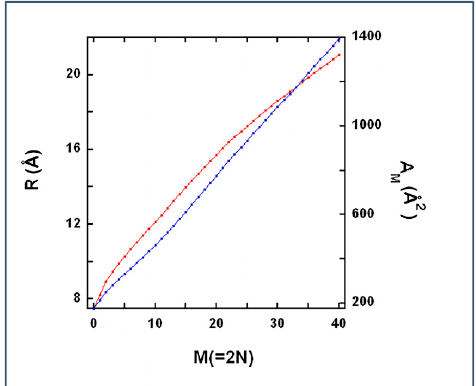
Figure 7. Condensing effect of gramicidin dimer. Red and blue curves are the radius, R and cross-sectional area, A M = R 2 π , respectively, of a rigid cluster as a function of the number of hydrocarbon chains, within a layer of the bilayer, condensed to a gramicidin dimer, M (=2 N). These curves were calculated from Equation (1) by using parameter values Rg = 7.5 Å [14]. R and A M are given in Å and Å 2 ,